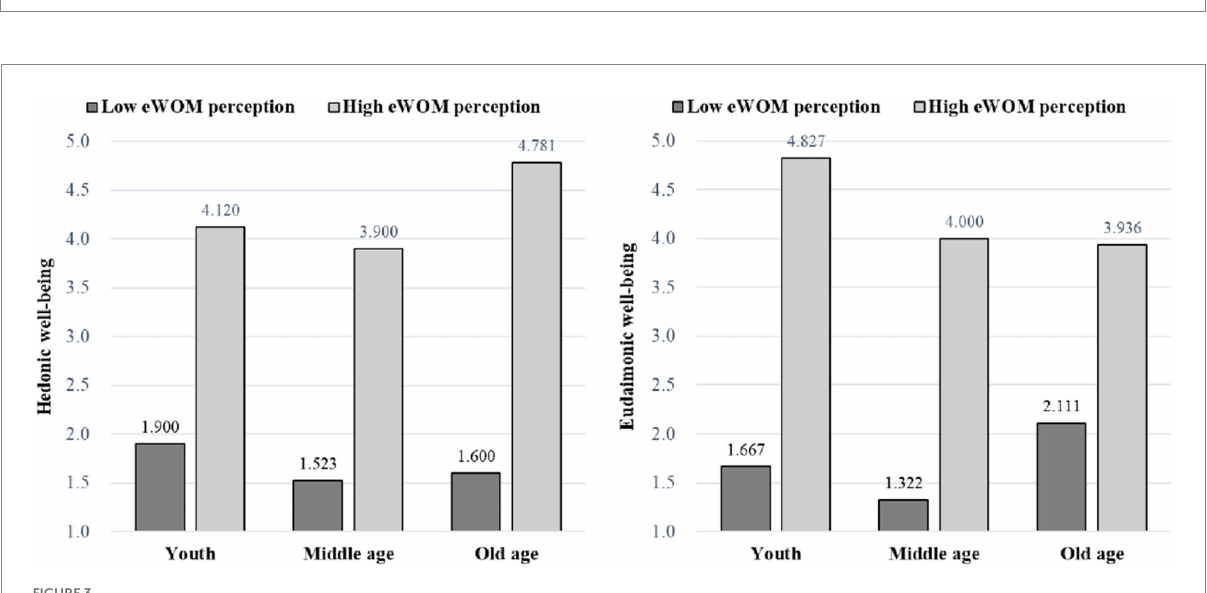
FIGURE 3 Interaction between eWOM perception and age